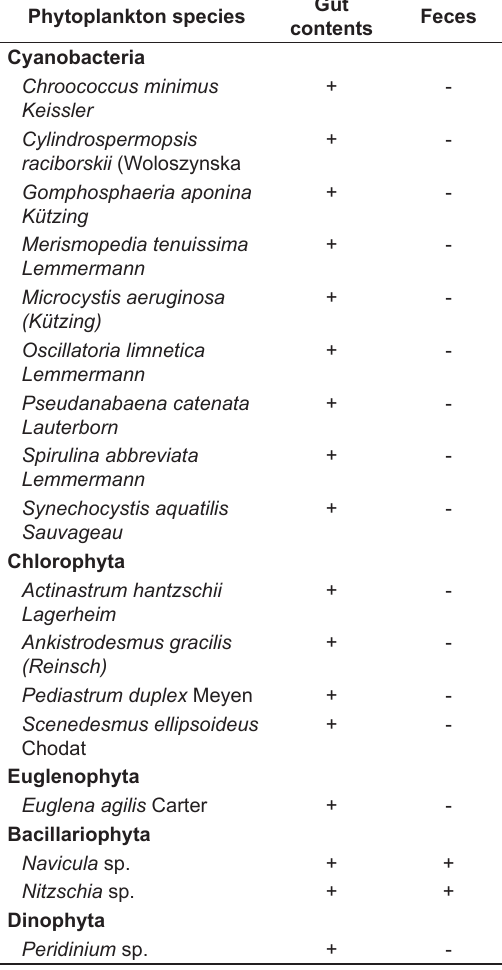
Table 5. Phytoplankton species in gut contents of tilapia fish collected from fishpond 3, and in feces after growing in aquarium containing filtered pond water for one